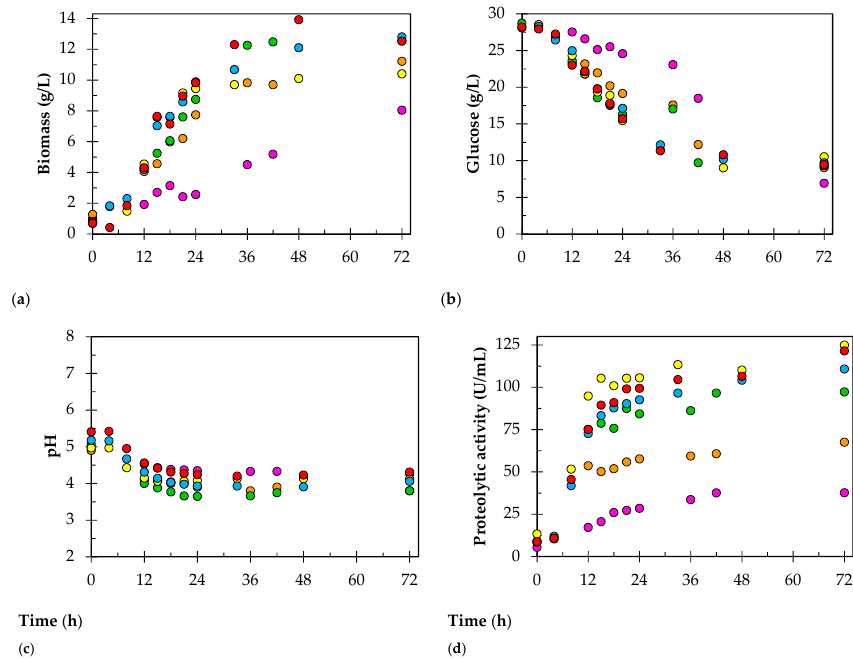
Figure 1. Representation of biomass concentration ( a ), glucose consumption ( b ), pH ( c ), and proteolytic activity ( d ) curves of R. mucilaginosa CBMAI 1528 in bioreactor under different k L a conditions: 18 h − 1 (purple, run 1), 49 h − 1 (orange run 2), 99 h − 1 (green, run 3), 121 h − 1 (yellow, run 4), 135 h − 1 (blue, run 5), and 102 h − 1 (red, run